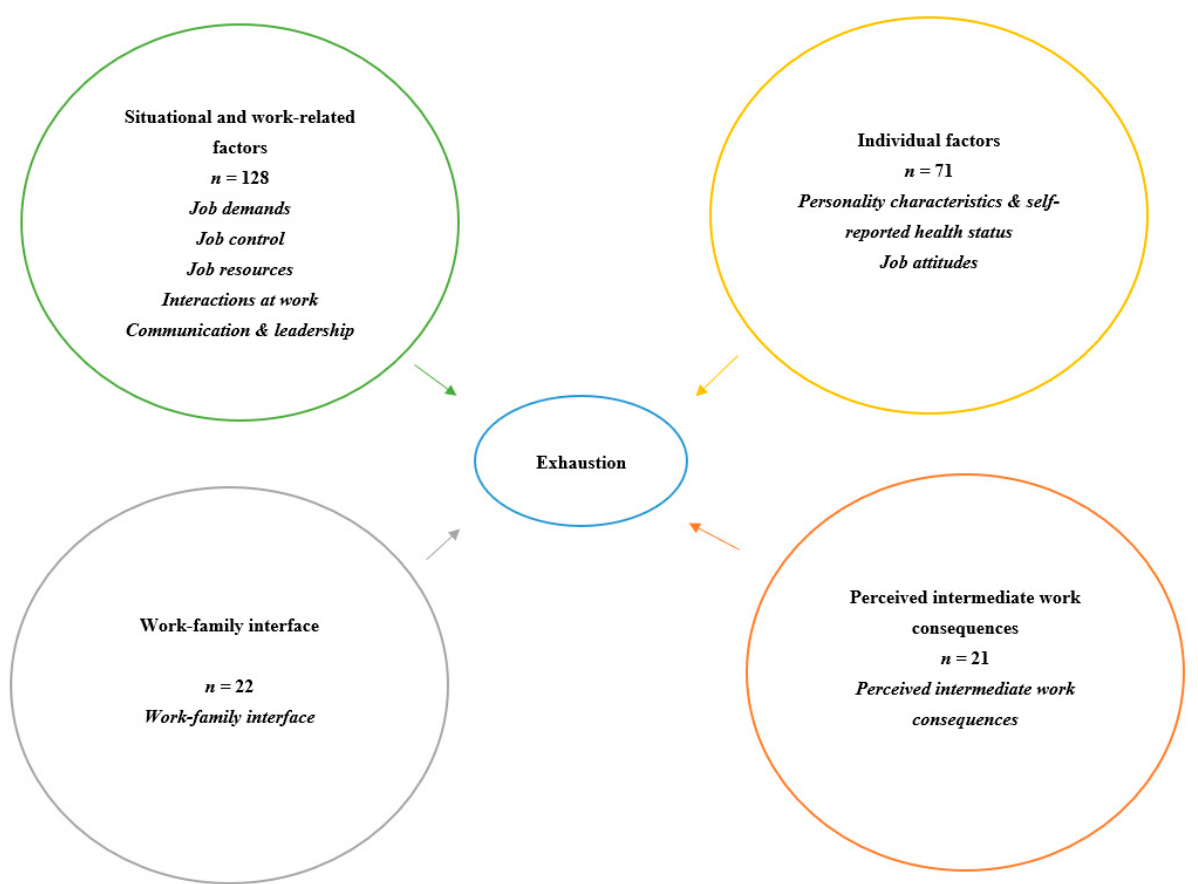
Figure 2. Description of the grouping of predictors in four families and nine subfamilies, shown in italics .